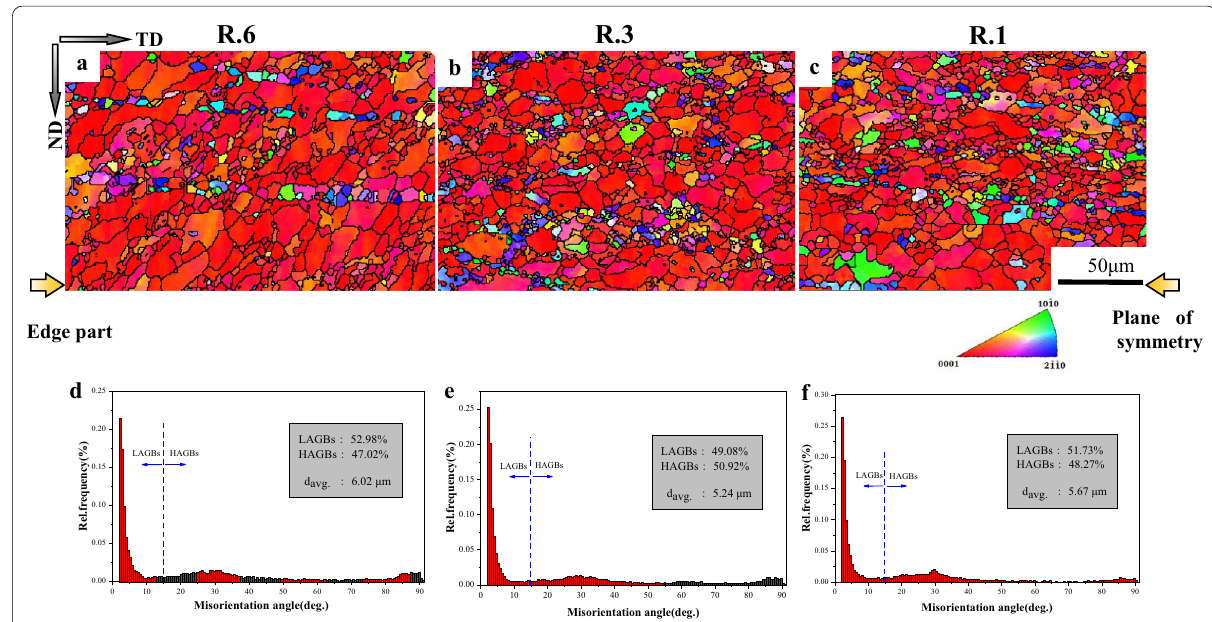
Figure 10 IPF maps and misorientation angle distribution near the center along the transverse direction of the as-rolled AZ31 plate with a thickness of 5.6 mm: ( a , d ) R6, ( b , e ) R3, ( c , f )